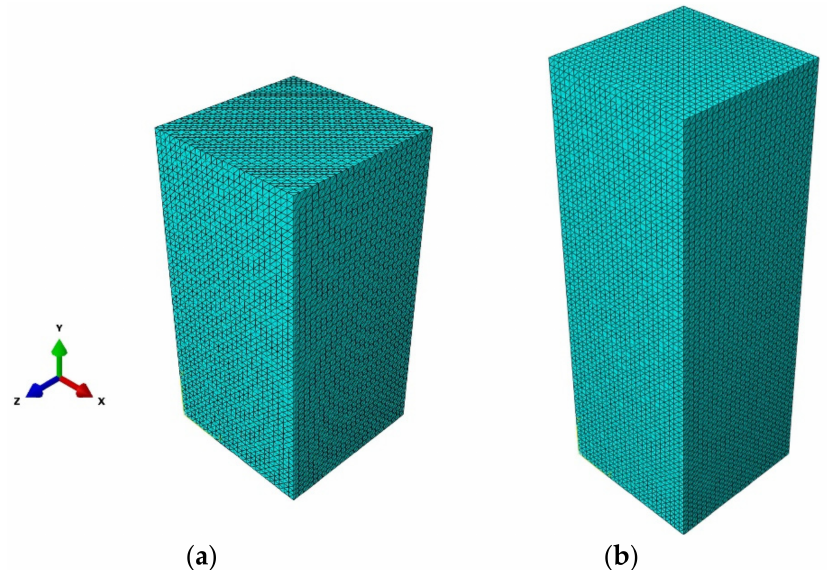
Figure 7. Geometrical modeling and finite-element resolution for URM: ( a ) Cascardi et al. [65] and ( b ) Sneed et al.